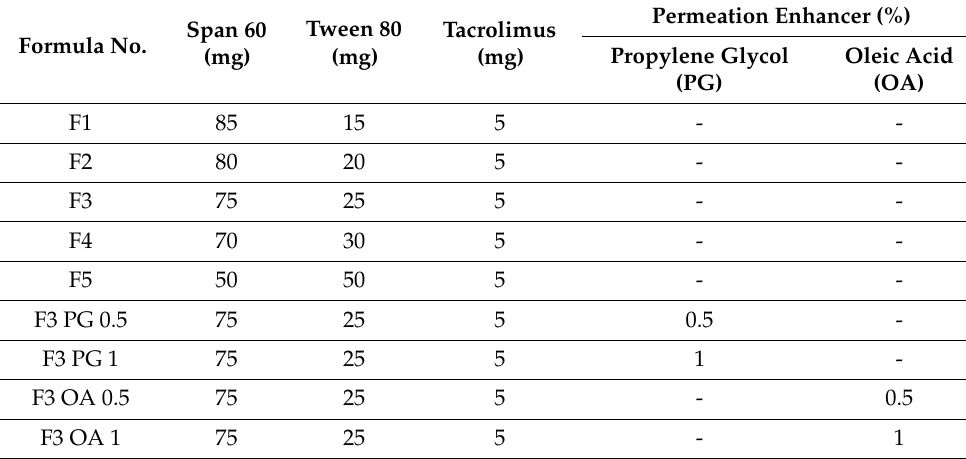
Table 1. Composition of different TCR-loaded SPL